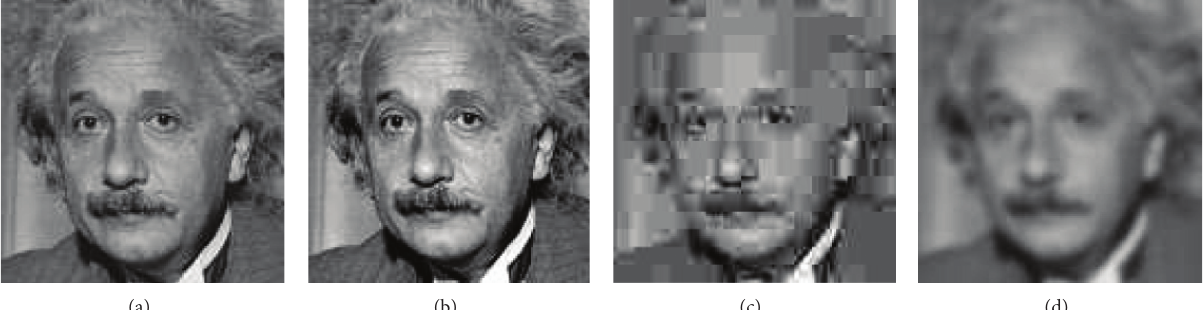
Figure 1: Example of three figures with different impairments and the same PSNR values: (a) original, (b) contrast stretched 26.55 dB, (c) JPEG compressed 26.60 dB, and (d) blurred 26.55 dB.